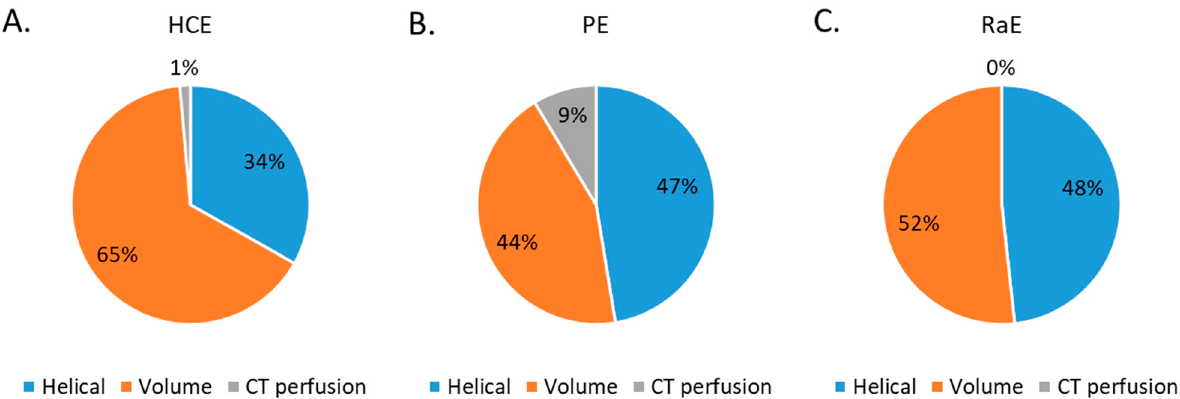
Figure 3. Percentage of CT acquisition types for all 3 embolization procedures. ( A ) HCE: hepatic chemoembolizations; ( B ) PE: pelvic embolizations for planned prostatic embolizations; ( C ) RaE: